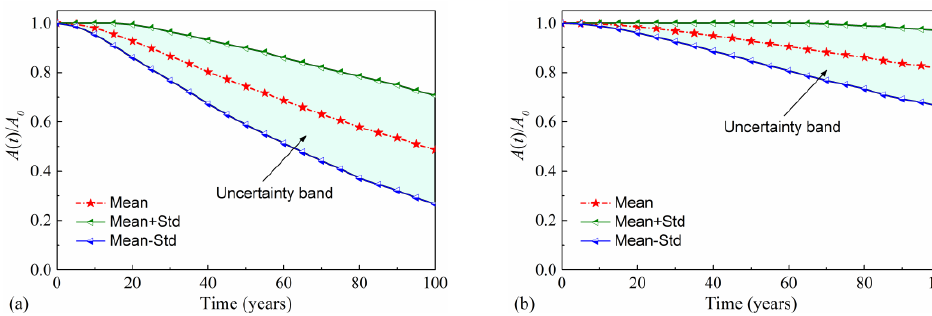
Figure 8. Time-variant NCSA of reinforcement: ( a ) splash and tidal zone; ( b ) atmospheric zone.